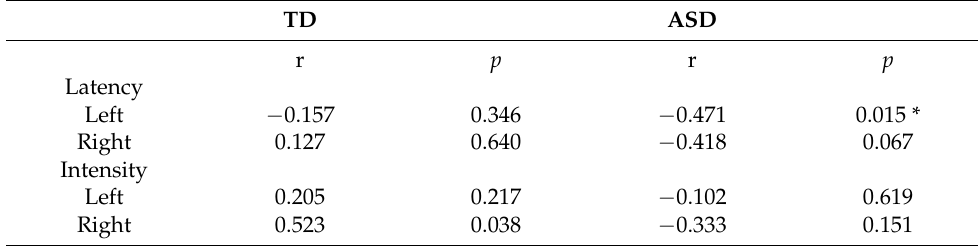
Table 2. Correlation between P1m latency/intensity and language